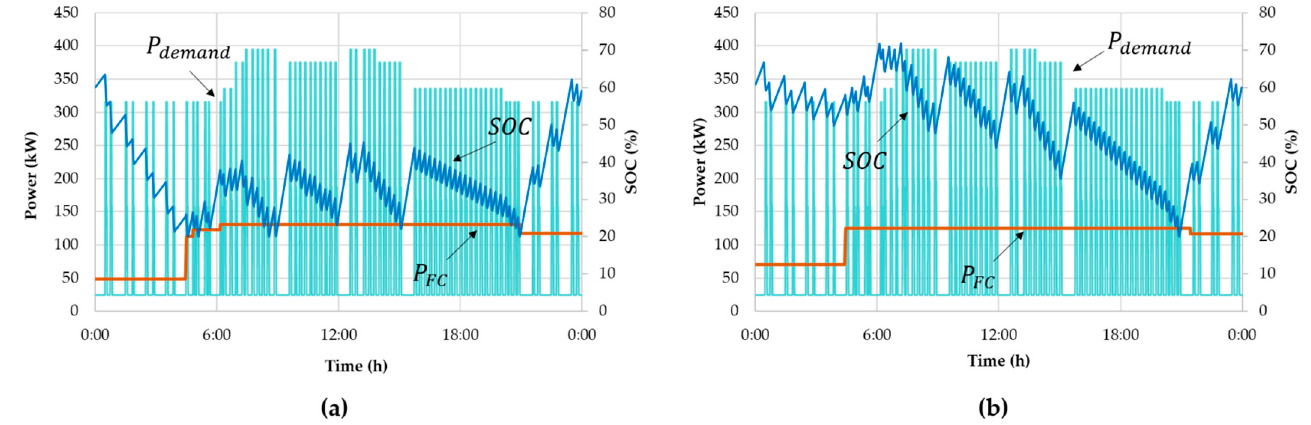
Figure 4. Health-conscious optimal daily operation of the ferry during the ( a ) first month and ( b ) last month of operation. Light blue lines represent the ferry power demand, orange lines the PEMFC output power, the blue lines the SOC of LFP battery.